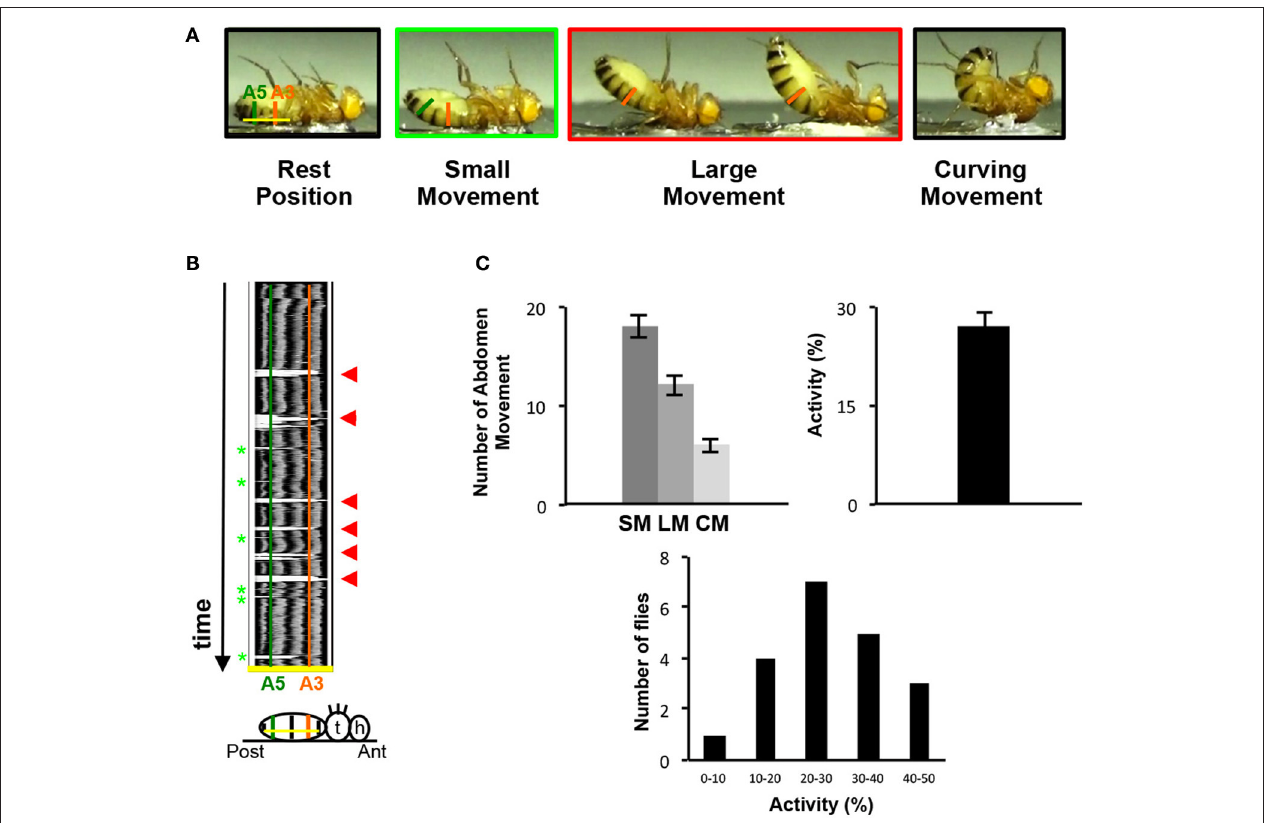
FIGURE 3 | The abdomen folding: A new behavioral test. (A) Control adult flies, thorax fixed on a glass slice move their abdomen. Depending on the amplitude of the abdominal movements, small or large movements are distinguished. Taken from movie sequences, fly into light the green rectangle illustrates small movement (SM) and large movement (LM) is highlighted in the red rectangle. The two extreme positions (black rectangles) are the resting position when the abdomen is parallel to the glass slice (left) or at the opposite the total curving of the abdomen when the abdomen is perpendicular to the slice glass (right, curving movement, CM). The baseline is represented by a yellow line at the resting position and the segment A3 and A5 are showed by vertical line orange and green, respectively. (B) Video recording could monitor the abdomen folding movement. Kymograph plot from video recording of the abdominal folding movement, which presents the spatial position of the fly abdomen over time along an axis. This axis is determined for each fly at resting position by a line from A2–A6 (baseline, yellow line in 3A). Each abdominal segment shows a dark pigmented tergite part easily visible on the kymograph. A3 and A5 are represented by vertical lines orange and green respectively. The movements of the abdomen during the record are visualized by the presence of white peak zones that correspond to the absence of pigmented tergite at that time and position. Small movements are associated with small white peaks at A5 position (light green asterisks) and the large movements correspond to the absence of tergite from A6 until A3 and generate large white peaks (red arrowheads). Below the kymograph, a fly pasted on the back is drawn in resting position. At the right side the head (h), the thorax (t) and the abdomen are represented. On the abdomen the baseline is in yellow and a green and orange vertical line respectively show the A5 and A3 segments aligned with the same region in the upper kymograph. (C) General folding behavior parameters. The number of small and large movements is counted from kymographs. The number of curving movements is determined from the movie. 20 control flies have been recorded during 1min twice, these flies perform 18 SM ( ± 1.09), 12LM ( ± 0.98) and 6 CM ( ± 0.7) in average and show 27% ( ± 2.46) of activity. The percentage of activity clusters all the abdominal movements executed by the sample of flies in average. This percentage is obtained from the kymograph (see Materials and Methods). The distribution of the percentage of activity for each control fly tested is represented by histograms. The percentage of activity varies between 8 and 47% with the class between 20 and 30% activity the most represented. The percentage of activity is calculated from the 40 videos recorded. The error bars represent the standard error of the mean ( ±